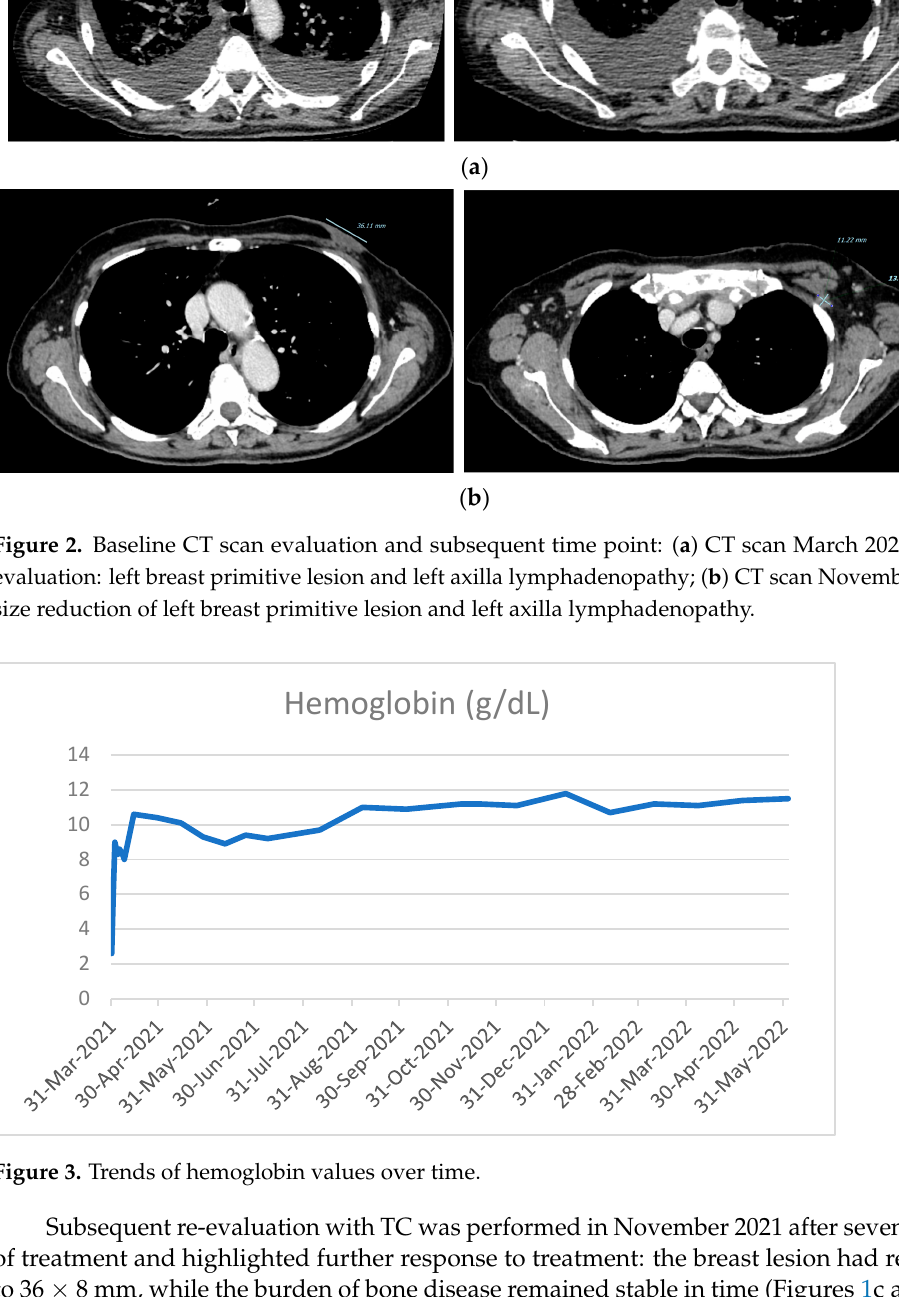
( a ) ( b ) Figure 4. Trend of CA15.3 ( a ) and CEA ( b ) over time.